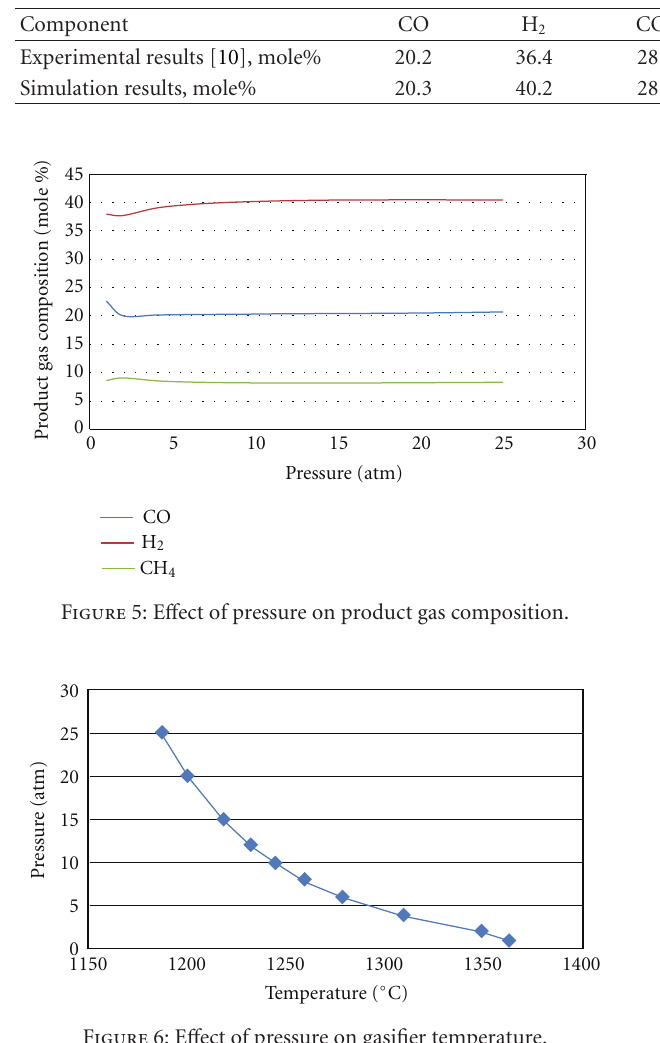
Figure 6: E ff ect of pressure on gasifier temperature.